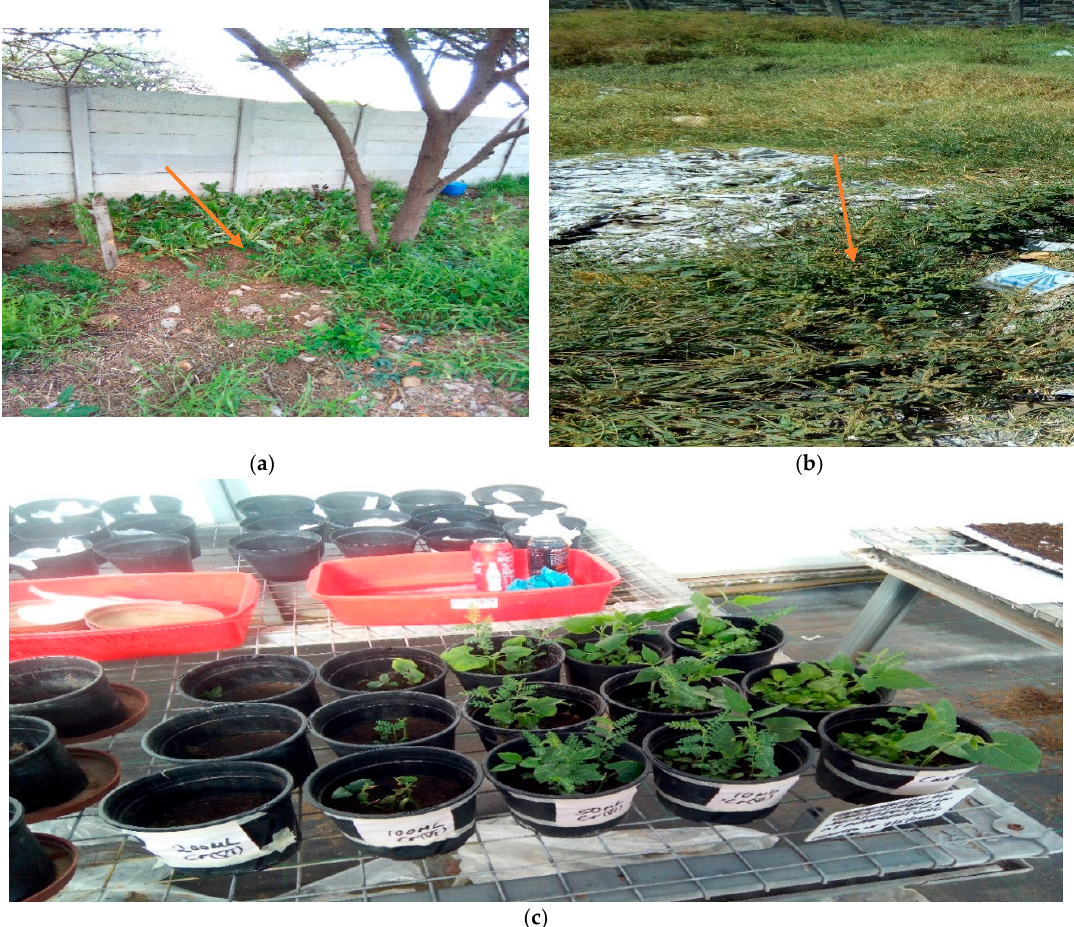
Figure 3. ( a ). Spinacia oleracea grown by tannery workers near tannery chromium wastes dumpsite in South Africa. ( b ) Amarantha dubuis Thell growing wildly in a tannery chromium wastes dumpsite in Kenya. ( c ) Experimental set up and germination of edible vegetables in Cr(VI) polluted soil in the University of South Africa (UNISA) greenhouse number 6.